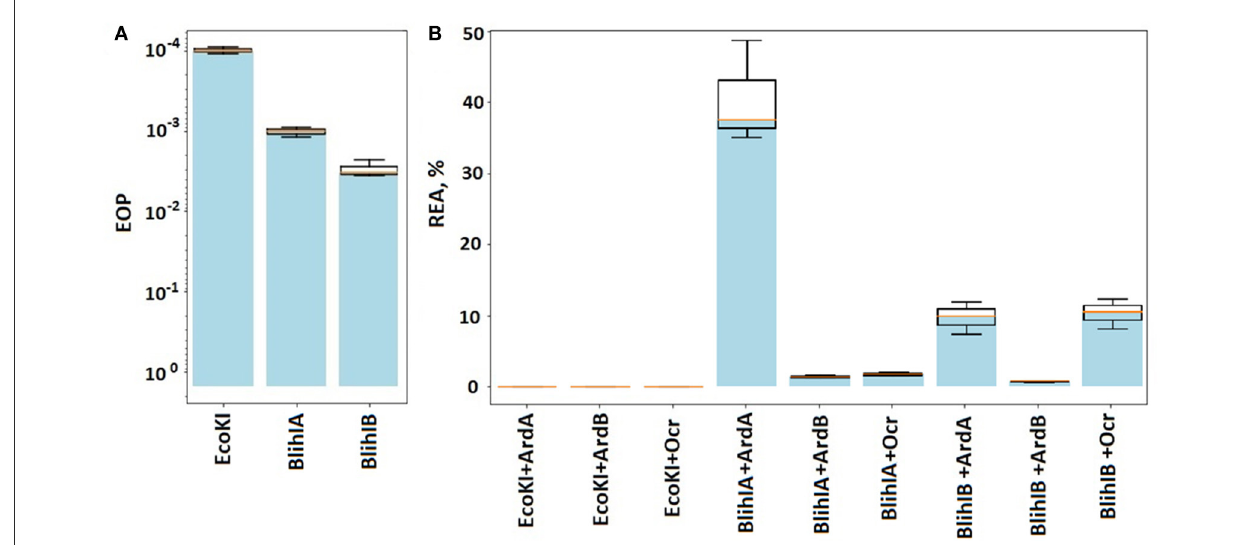
FIGURE3 The efficiency of defense provided by RMI systems. (A) Results of the λ 0 phage plaquing (EOP) on a lawn of E. coli cells containing genes of various RMI systems of gram-positive bacteria compared to the EcoKI system. Columns: EcoKI – TG1pVMC3, BlihIA – TG1pIRal-2_RM-Ia, and BlihIB – TG1pIRal-2_RM-Ib. (B) Antirestriction activity of ArdA, ArdB, and Ocr proteins. Residual endonuclease activity (REA) represents the activity of endonuclease in the presence of antirestriction proteins. Columns: EcoKI + ArdA – TG1pVMC3p15araArdA, EcoKI + ArdB – TG1pVMC3p15araArdB, EcoKI + Ocr – TG1pVMC3p15araOcr, BlihIA + ArdA – TG1pIRal-2_RM-Ia-p15araArdA, BlihIA + ArdB – TG1pIRal-2_RM-Ia – p15araArdB, BlihIA + Ocr – TG1pIRal-2_RM-Ia – p15araOcr, BlihIB + ArdA – TG1pIRal-2_RM-Ib – p15araArdA, BlihIB + ArdB – TG1pIRal-2_RM-Ib – p15araArdB, and BlihIB + Ocr – TG1pIRal-2_RM – Ib –